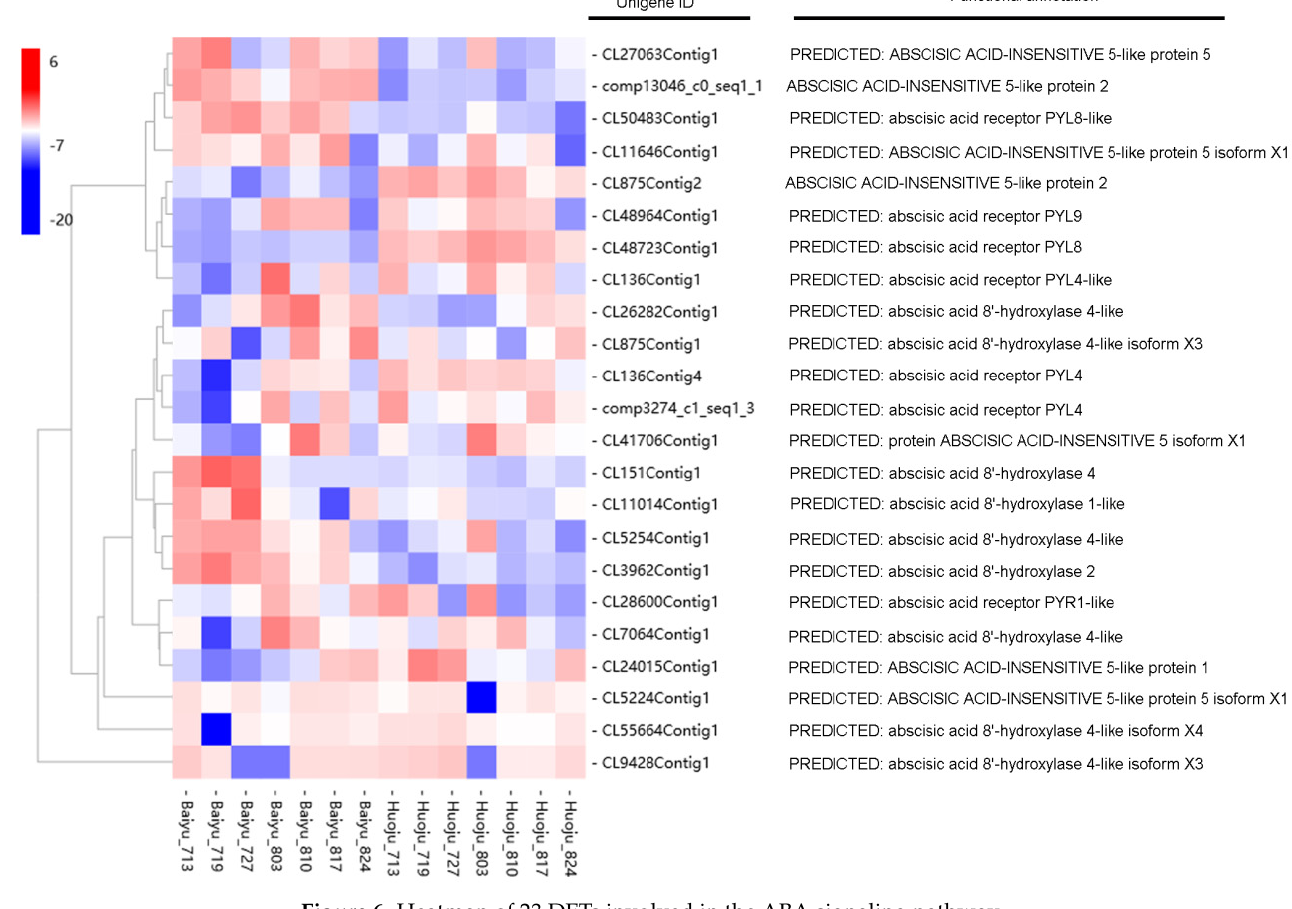
Figure 6. Heatmap of 23 DETs involved in the ABA signaling pathway. We selected eight DETs associated with the ABA signaling pathway, namely, EjABH2 (CL3962Contig1), EjABH4 (CL151Contig1), EjABH4-like (CL9428Contig1), EjABH4-like2 (CL5254Contig1), EjPYL4 (CL136Contig4), EjPYL4-like (CL136Contig1), EjPYL8 (CL48723Contig1), and EjABI5-like (comp13046_c0_seq1_1). We then determined the relative differences in their expression levels during ‘Baiyu’ and ‘Huoju’ flower bud differentiation (Figure 7; Figure 8). The qRT-PCR evaluated the expression profiles of the foregoing ABA signaling-related DETs, and the output of this analysis showed good agreement with the RNA-Seq data (Figures 7, 8, S5 and S6). EjABH2, EjABH4, and EjABH4-like2 were significantly upregulated in the apical buds of ‘Baiyu’ compared with those of ‘Huoju’, especially at the early stage of 13 July (T0) to 3 August (T3). Hence, these DETs might play vital roles in regulating flowering time. However, EjABH4-like was upregulated in ‘Huoju’ but downregulated in ‘Baiyu’ between 13 July (T0) and 27 July (T2). Therefore, EjABH4-like might negatively regulate flowering time (Figures 7 and S5). The ABA receptor EjPYL4-like was significantly upregulated on 3 August (T3), especially in ‘Baiyu’. At that time, both EjPYL4 and EjPYL8 were upregulated in ‘Huoju’ compared with ‘Baiyu’ (Figures 8 and S6). EjABI5-like was upregulated in ‘Baiyu’ throughout bud differentiation (Figures 8 and S6).